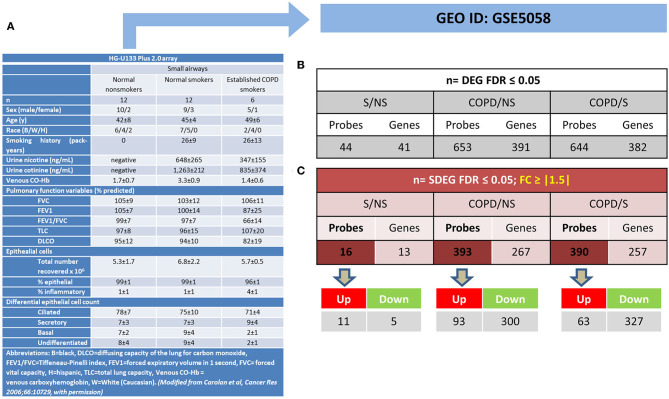
Regulated mRBP expression in Small Airway Epithelial Transcriptomics in stable COPD. (A) Clinical and spirometric phenotyping of COPD smoker patients (COPD), non-smokers (NS), and smokers (S) with normal lung function (NLF) as control cohorts providing small airway epithelial cells by bronchial brushings for trascriptomic analysis reported in GEO GSE5058 [modified from (17) with permission] utilized in this study for mRBP expression analysis. (B,C) For each gene, multiple probes spanning different gene regions are represented on array platforms. Panels show the numbers of mRBP probes and corresponding genes obtained after FDR filtering (see Figure 1A). (B) Statistically significant, Differentially Expressed mRBP Genes, regardless of fold change value (DEG) and (C). Statistically Significant/Differential Expressed mRBP Genes with differential expression set at ≥ |1.5) (SDEG) obtained comparing datasets from S vs. NS, COPD vs. S and vs. NS. Number of Up- or down-regulated SDEG probes are shown below.